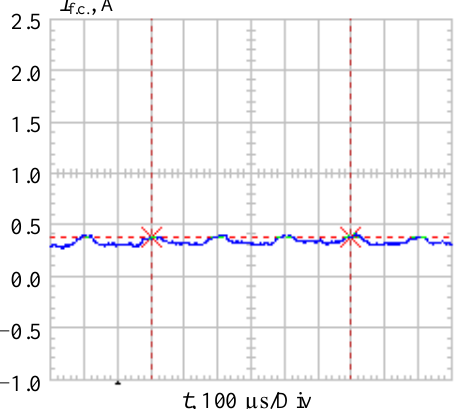
Fig. 11. Current of the fuel cell with rms 0.66 A in the case when load is partially powered by the fuel cell without a load filter.